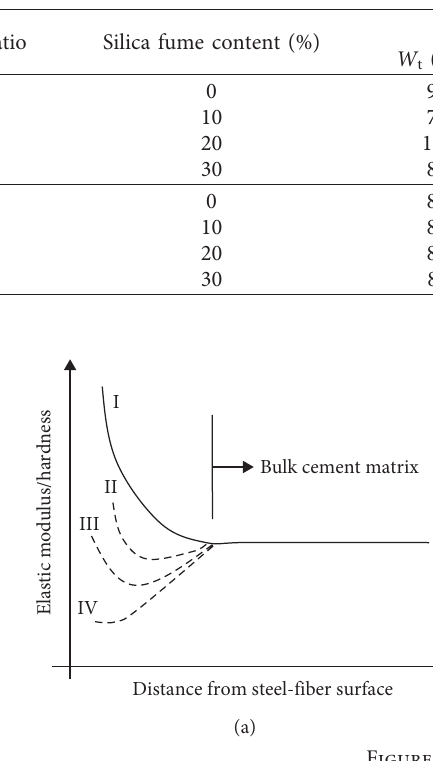
Table 6: W t and η for different water-binder ratios and silica fume contents.